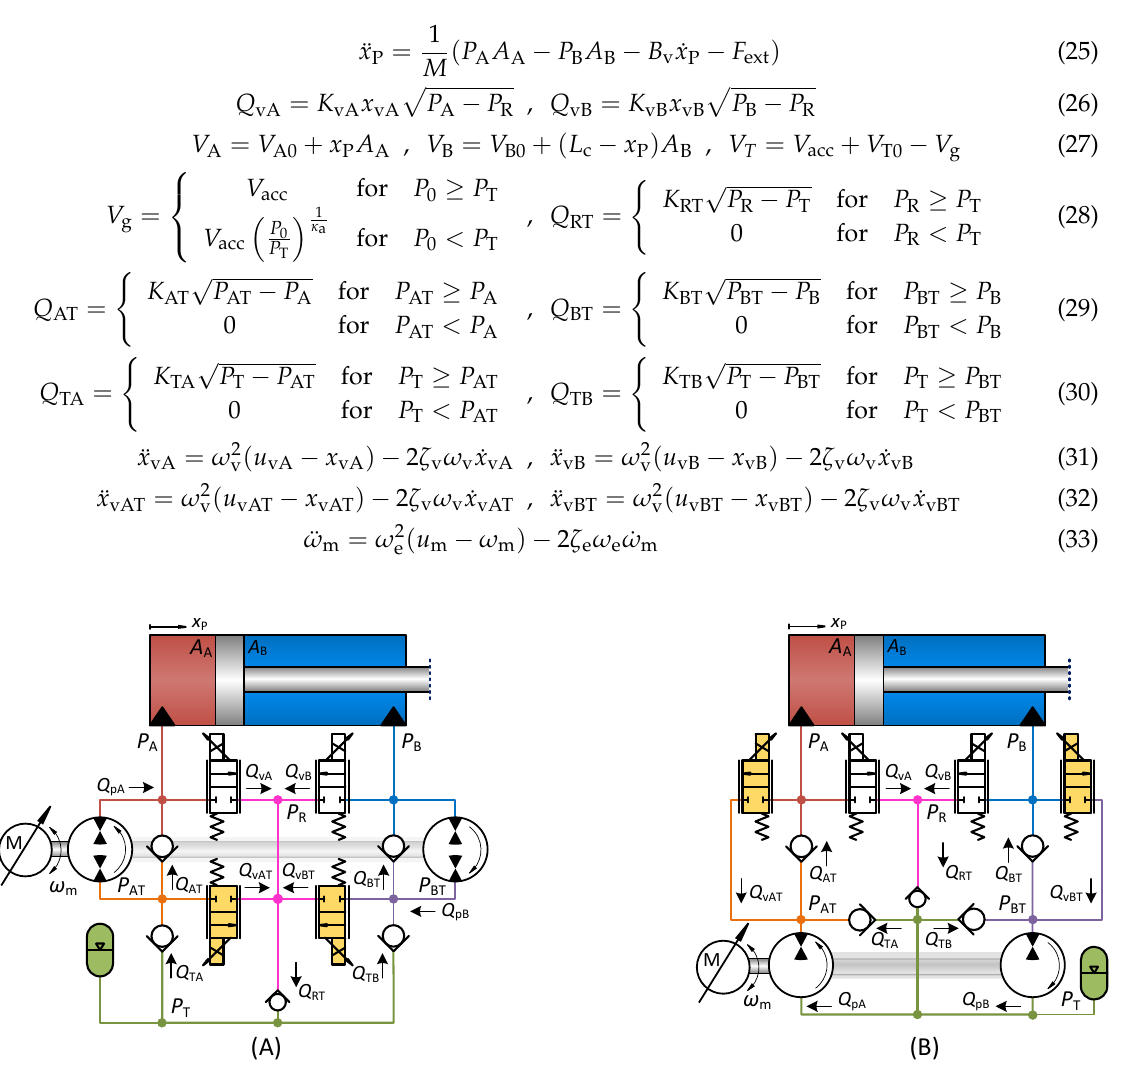
Figure 7. Drive Schematics with nomenclature used for modeling. ( A ) DPCS-R drive schematics. ( B ) DPDS-R drive